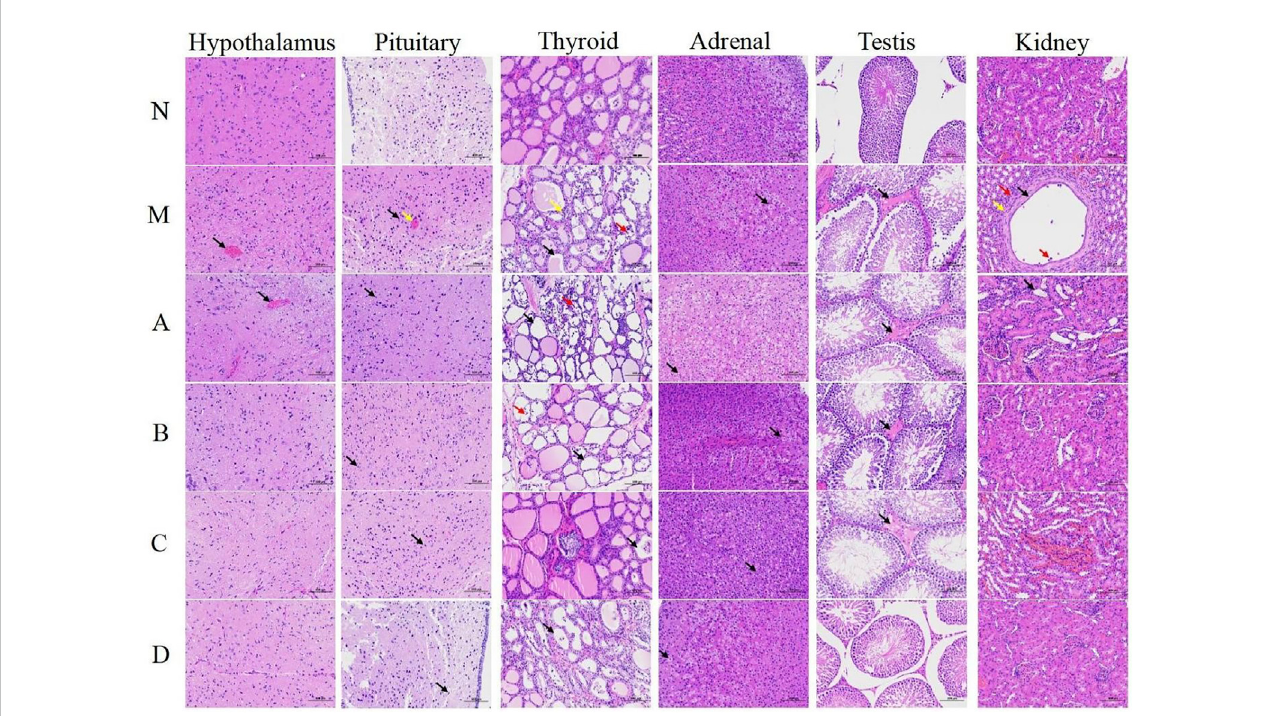
FIGURE 3 H&Estainingofhypothalamus,pituitary,thyroid,adrenal,testisandkidneytissuesections(magni fi cation×200).N,normalgroup;M,modelgroup;A,suet oil group; B, Epimedium raw product group; C, Epimedium heating product group; D, Epimedium fried with suet oil group. Hypothalamus: Black arrow represents the bleeding. Pituitary: Yellow arrow represents the bleeding. Black arrow represents the cell nucleus and the cytosolic boundary. Thyroid: Black arrowrepresentsthefollicularmatrix.Yellowarrowrepresentsepithelialcellnecrosis. Redarrowrepresentsnuclearfragmentation.Adrenal: Blackarrow represents parenchymal cell degeneration. Testis: Black arrow represents eosinophilic serous material. Kidney: Black arrow represents the renal tubules. Yellow arrow represents the connective tissue. Red arrow represents the cellular in fi